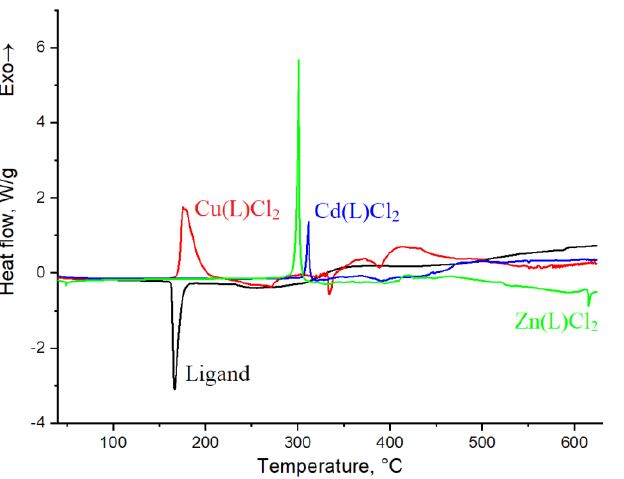
Figure 9. DSC scans of investigated materials.